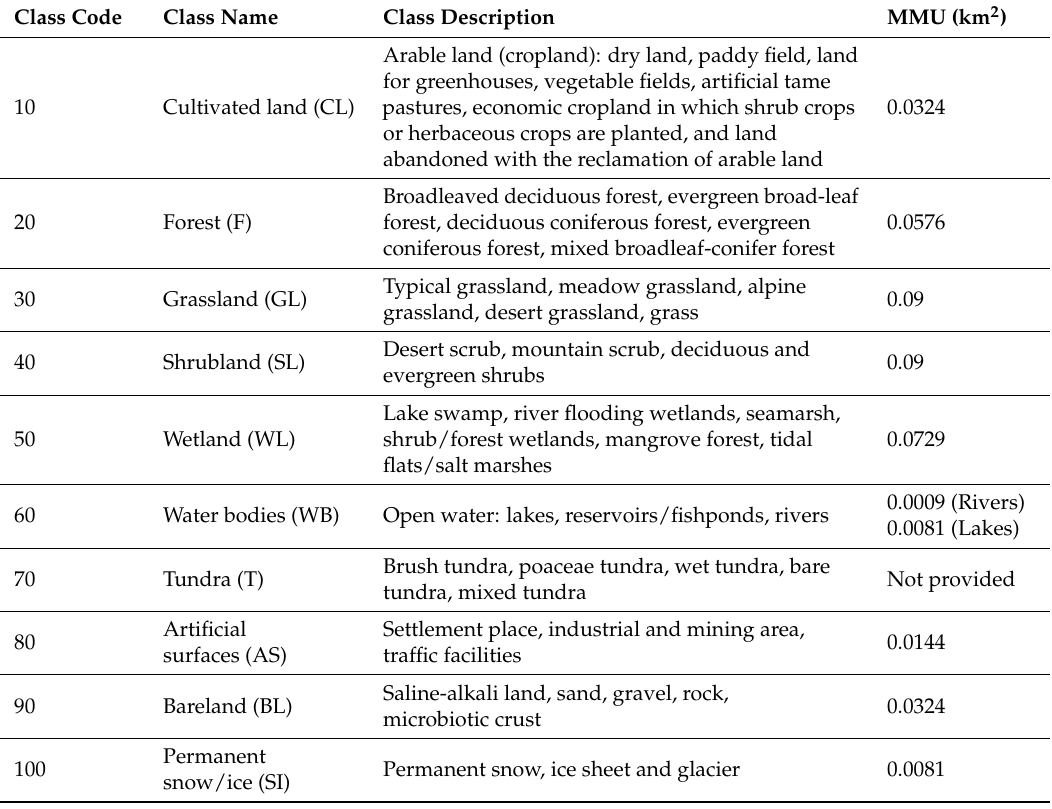
Table 1. GlobeLand30 (GL30) nomenclature. MMU: minimum mapping